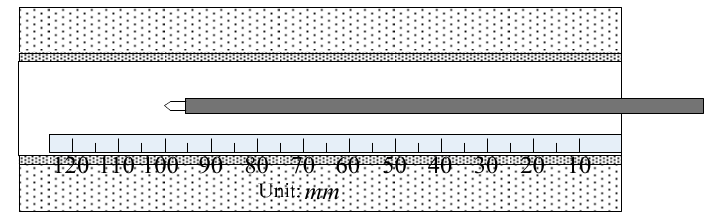
Figure 4. Schematic diagram of temperature measurement positions in high temperature furnace.